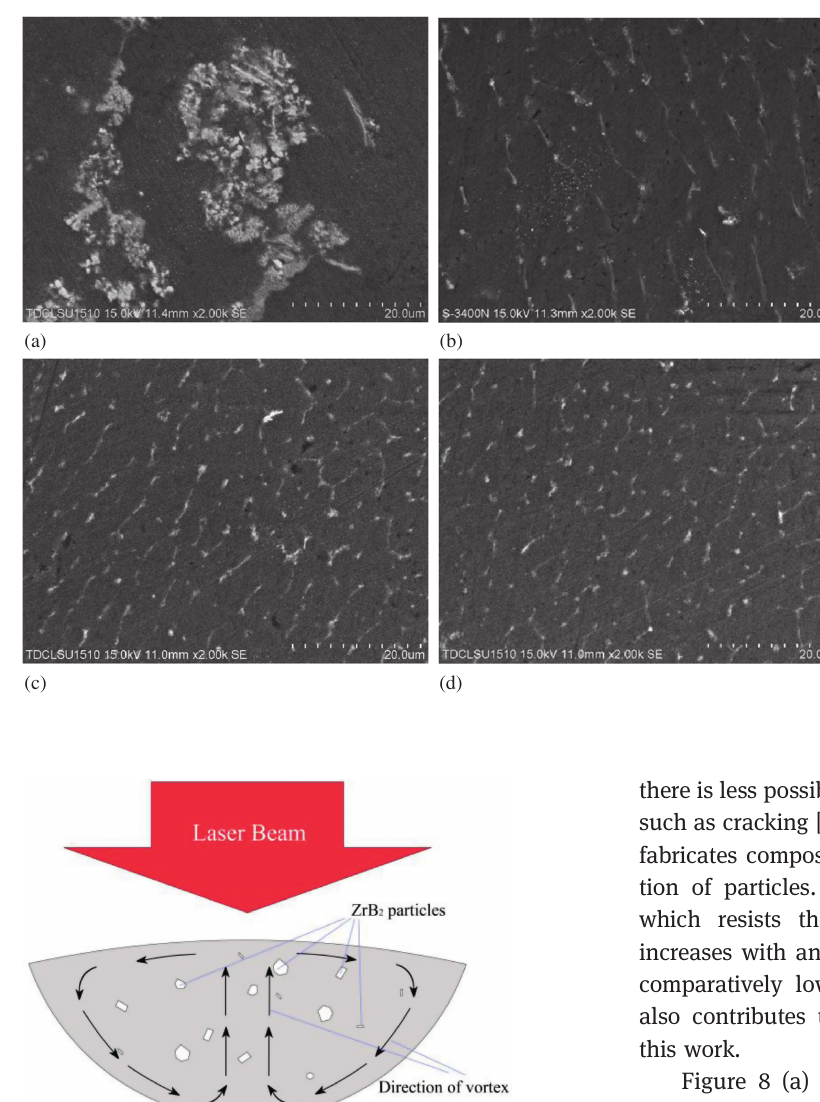
Figure 7: Schematic of ZrB 2 particle movement in melt pool during